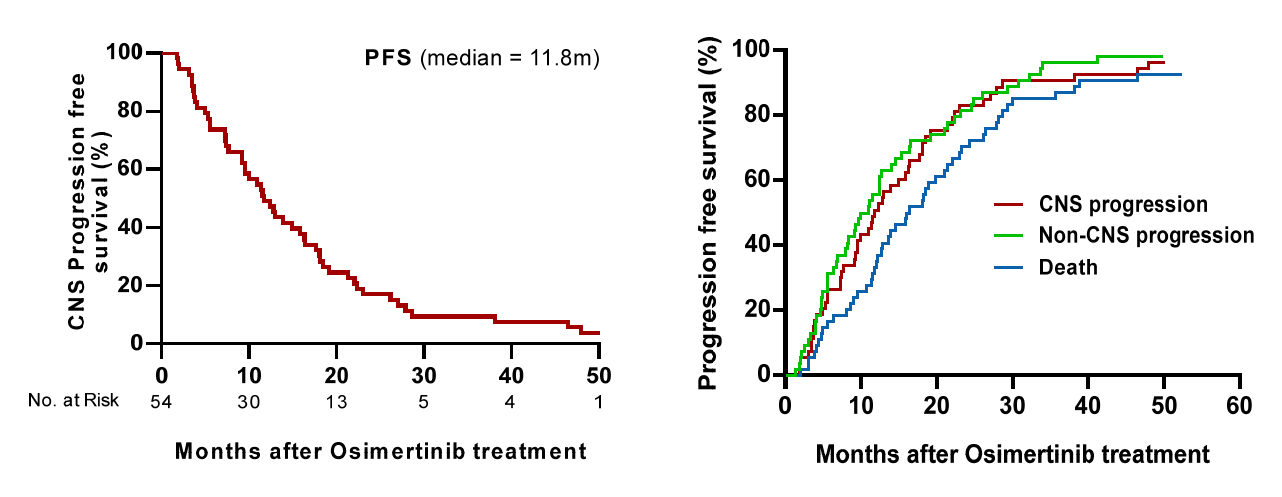
Figure 4. ( A ) Kaplan–Meier estimates of CNS progression-free survival (CNS full analysis set). ( B ) Cumulative incidence of CNS progression, taking into account competing risks of non-CNS progression and death by any cause (CNS full analysis set). The cumulative incidence function was calculated using a Fine and Gray model.